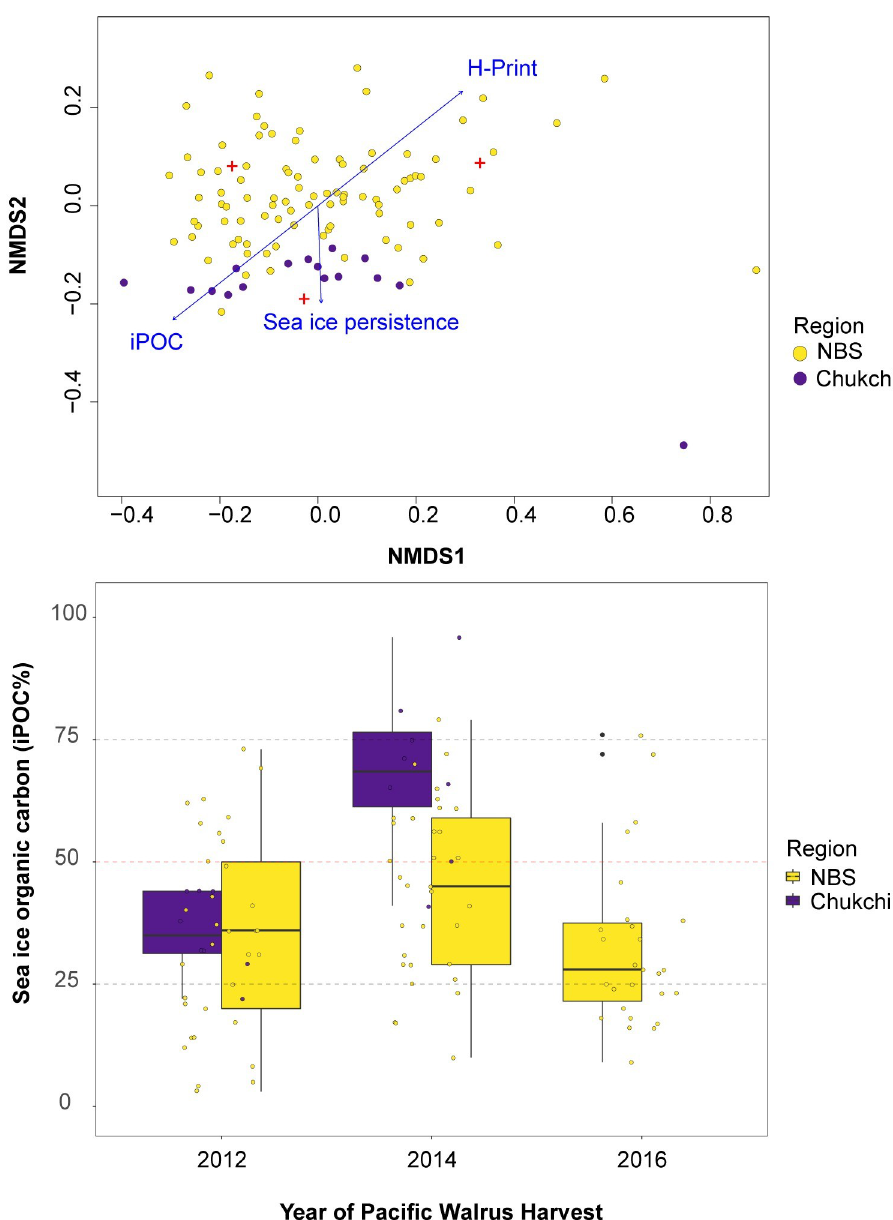
Fig 4. Regional analysis of sea ice organic carbon. a) Ordination plots based on the individual highly branched isoprenoids (HBIs), including IP 25 , HBI II and HBI III, used to calculate sea ice organic carbon (iPOC) content. Data points are colored by region and the considered environmental vectors as blue arrows. b) Boxplots for iPOC (%) by year and region. Boxes depict the interquartile range from the first to third quartiles, including the median (horizontal line), minimum/maximum (vertical lines) and outliers (individual points). (iPOC, H-Print and sea ice persistence) indicate a stronger association with ice algae contribu- tions (i.e. iPOC) and sea ice persistence on the Chukchi Sea walruses while there were greater associations with phytoplankton contributions (i.e. H-Print) on the NBS walruses. Two-way ANOVA tests indicated that region was a significant factor (DF = 1, F = 8.32, p < 0.01), as well as sex (DF = 1, F = 10.51, p < 0.01). The adjusted iPOC values (mean ± SE) in livers were highest